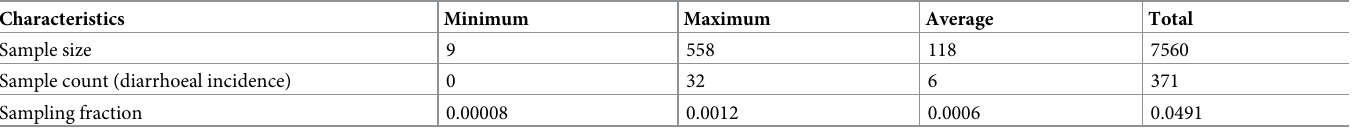
Table 1. Summary of sample size and sample count in 2014 BDHS data.